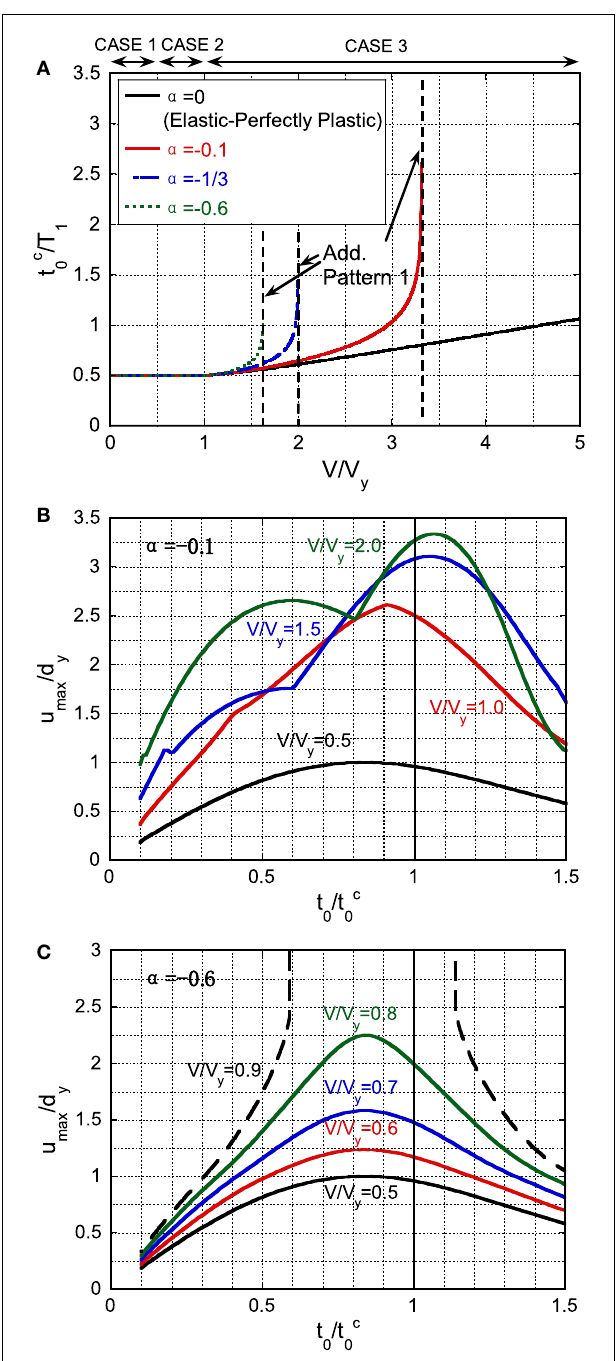
FIGURE 13 | Critical timing of double impulse with respect to input level and correspondence of critical timing between double impulse and the corresponding one-cycle sine wave: (A) critical timing of double impulse with respect to input level, (B) maximum deformation of model with ααα =–0.1 under sine wave with respect to t 000 = t c 000 , and (C) maximum deformation of model with ααα =–0.6 .